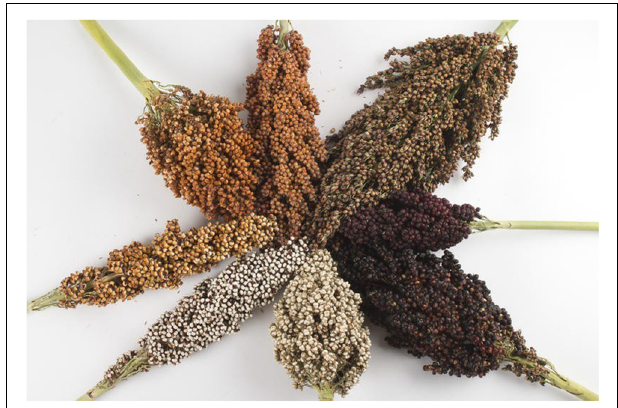
FIGURE 5 | Different genotypes of sorghum grain: black pericarp, red pericarp, white pericarp, brown pericarp, and orange pericarp varieties. Selection of the most potent varieties of sorghum is crucial for health and medical-related purposes. Picture adopted from Barmac